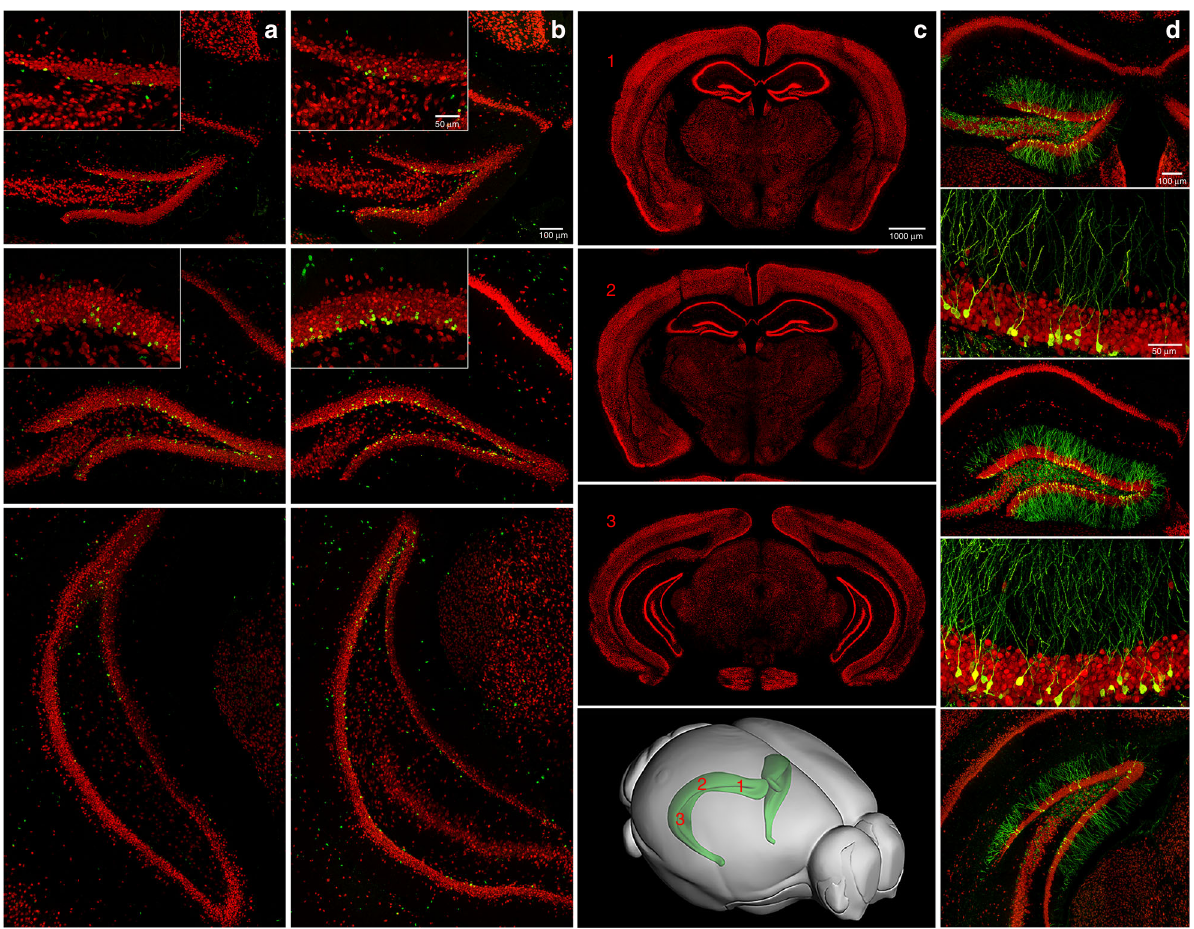
Fig. 1 Adult neurogenesis in the dentate gyrus of the hippocampus. a , b Photomicrographs of brain sections throughout the rostral-caudal extent of the hippocampal dentate gyrus (DG), immuno fl uorescently double-labeled with BrdU (green) and NeuN (red), derived from adult C57Bl/6 mice housed under ( a ) control or ( b ) running conditions for 4 weeks. BrdU (50 mg/kg, i.p.) was injected daily for the fi rst 10 days. The BrdU + cell numbers in the DG granule cell layer are ( a ) 22, 46, 41, and ( b ) 44, 120, 52, respectively, from top to bottom. c Representative overview panels (distance from Bregma 95 rostral to caudal: 1: − 1.34 mm, 2: − 1.94 mm, 3: − 3.64 mm) of coronal sections through the hippocampus, labeled with NeuN (red). Lower panel: 3-D brain diagram shows the hippocampus (green) with numbers (1,2,3, red) corresponding approximately to section bregma levels in the panels above. d Photomicrographs of adult-born DG neurons with elaborate dendritic processes, targeted by retrovirus expressing green fl uorescent protein (GFP) at one month after stereotaxic injection of retrovirus into the DG. Retrovirus labels dividing cells that develop into neurons over weeks. Coronal sections (40 μ m), derived from adult C57Bl/6 mice, were co-labeled with NeuN